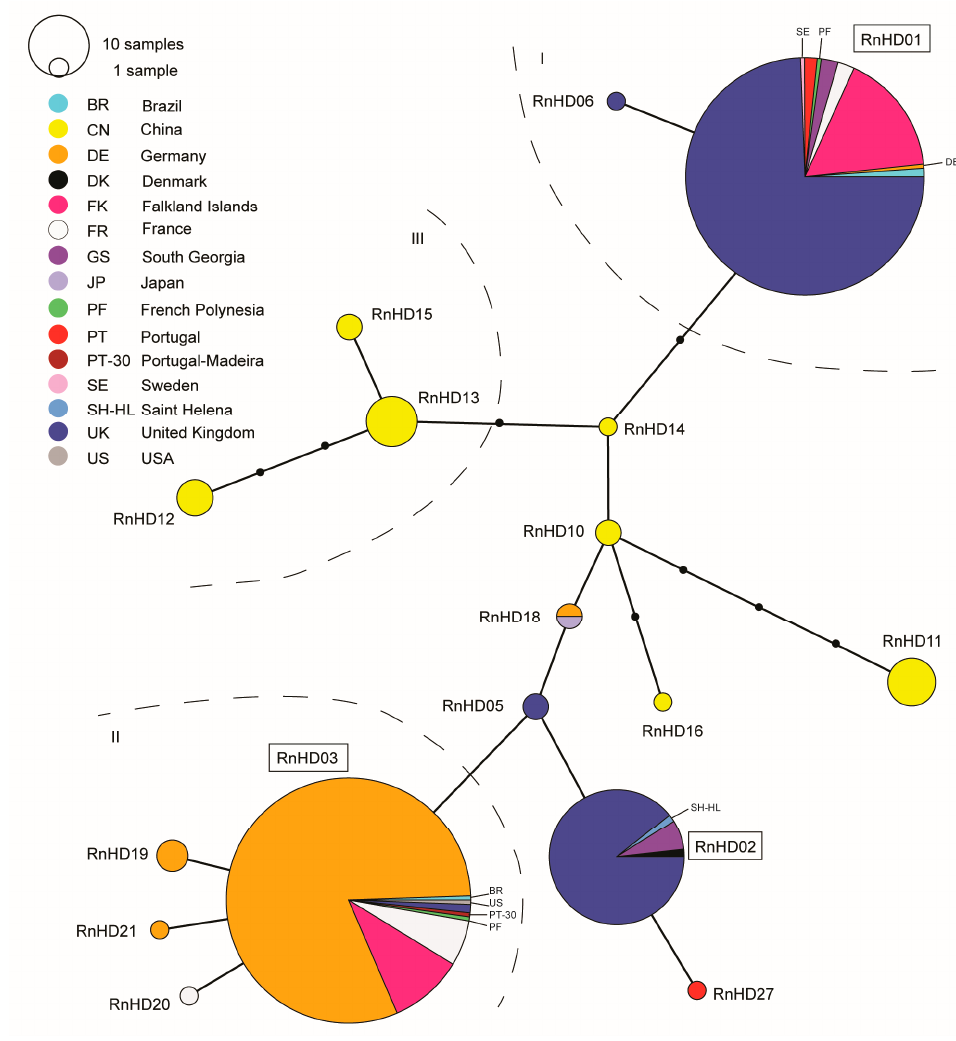
Figure 3. Median Joining network of 17 mtDNA D-loop haplotypes of R. norvegicus (364 bp; indel not distinguished; 1-step-edges shown). Diameter indicates abundance among 451 samples from this study and GenBank sequences. Haplotypes found in the South Atlantic are highlighted by boxes, supported clades within the Bayesian consensus tree circled and numbered corresponding to Figure 2. Locations indicated by ISO 3166-2 code (http://www.iso.org/iso/country_codes) and smallest wedges annotated within network.